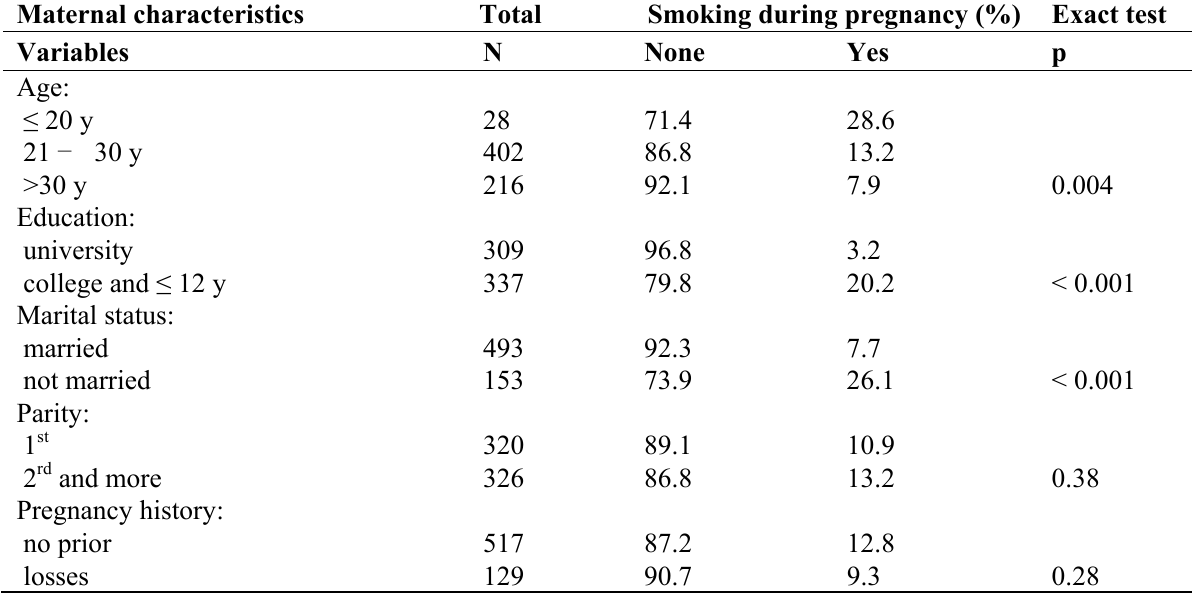
Table 1. Percent distribution of subjects by smoking for various characteristic and pregnancy outcomes. Maternal characteristics Total Smoking during pregnancy (%) Exact